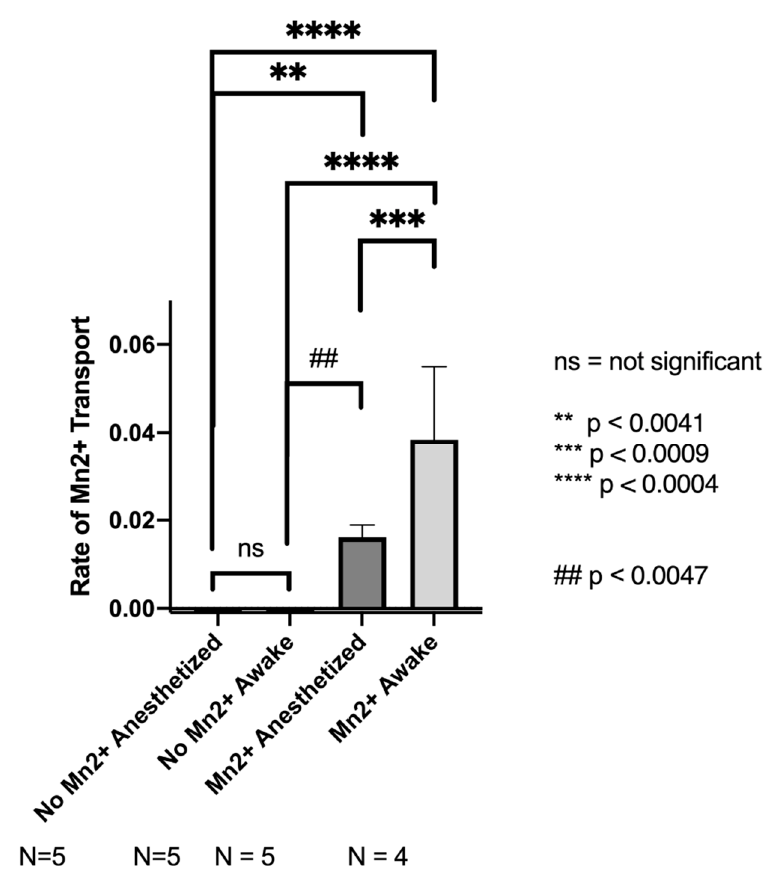
Figure 7. The mean rate of axonal transport of Mn 2+ (signal intensity/time) in the olfactory bulb of anesthetized animals (0.0161) was significantly lower than the mean rate of axonal transport of Mn 2+ in the olfactory bulb of awake animals (0.03869). The first two columns labelled “No Mn 2+ Anesthetized” and “No Mn 2+ Awake” do not contain observable signal because no Mn 2+ was administered to these